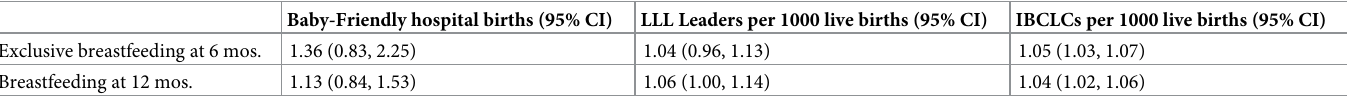
Table 2. Adjusted incidence rate ratios estimating multivariable associations between state-level breastfeeding support and breastfeeding practices for births in the U.S. in 2015 (n = 50), controlling for women’s